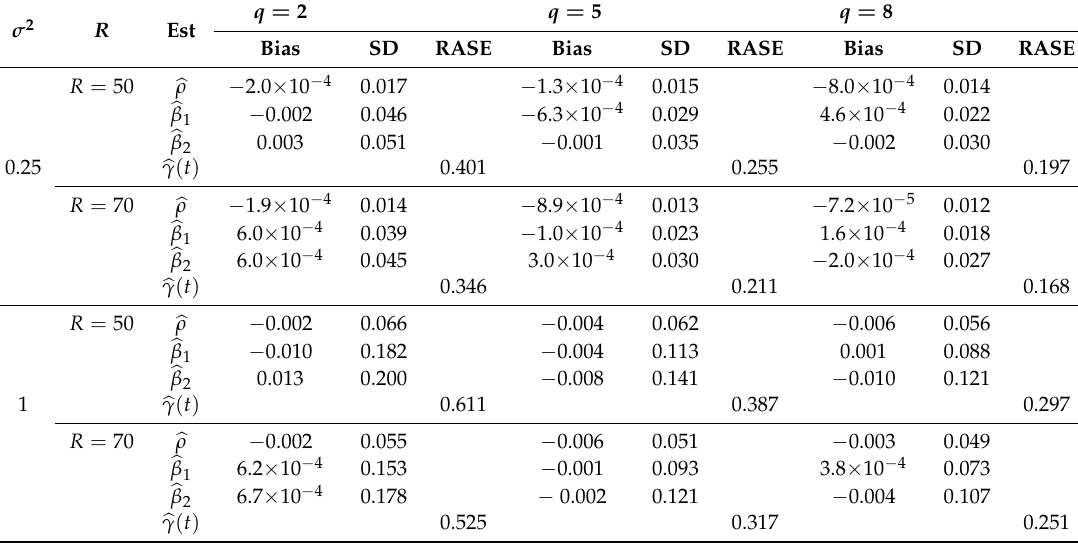
Table 2. Simulation results for ρ =